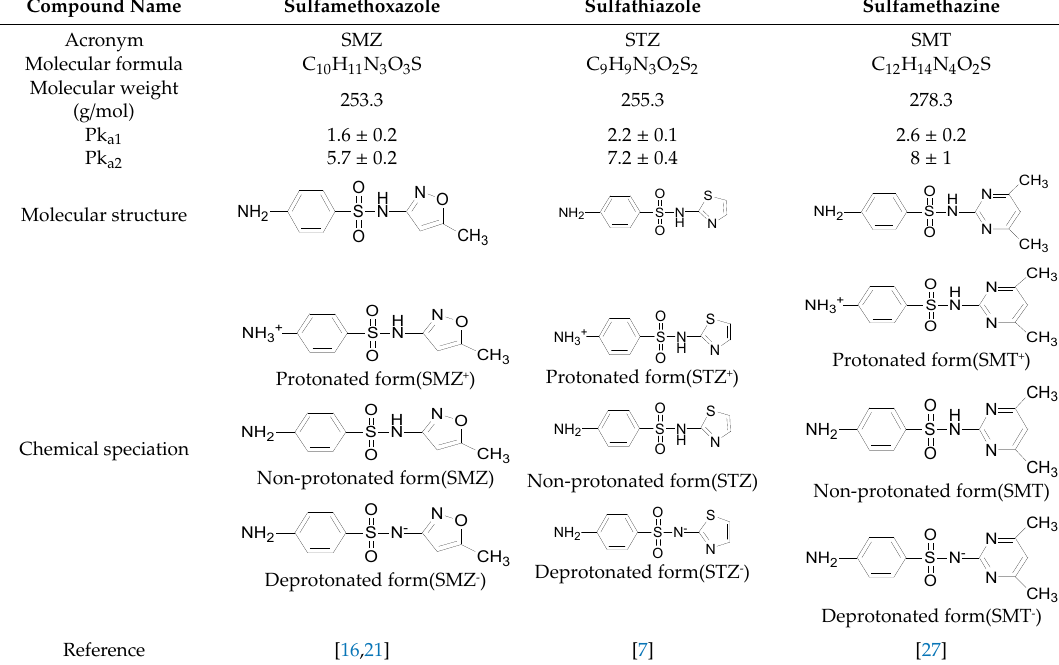
Table 1. Chemical structures and relevant data for selected sulfonamides.